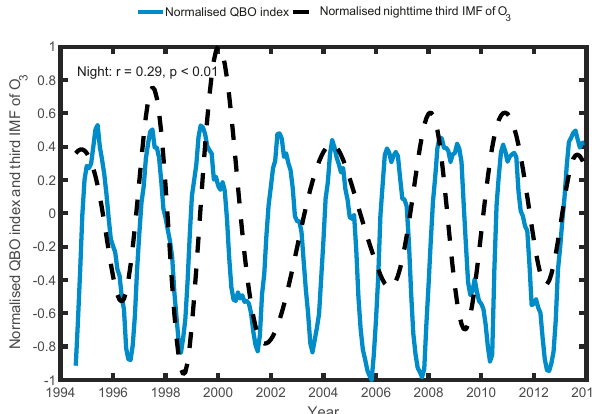
Figure 13. Comparison between the normalised nighttime (dashed black line) third IMF and the normalised 30hPa QBO index (solid blue line) during